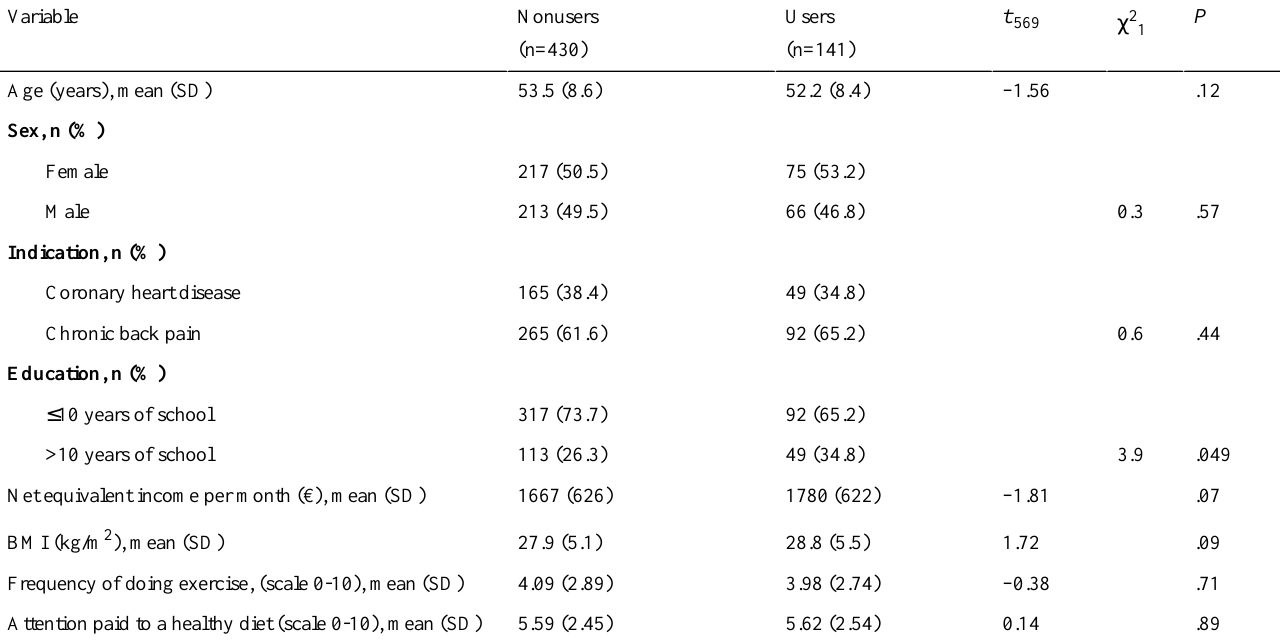
Table 4. Baseline characteristics—as-treated analysis.